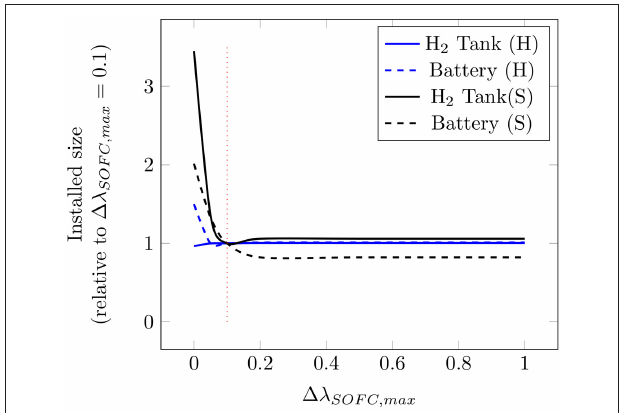
FIGURE 10 | Parametric analysis of the influence of the maximum allowed load change for the SOFC